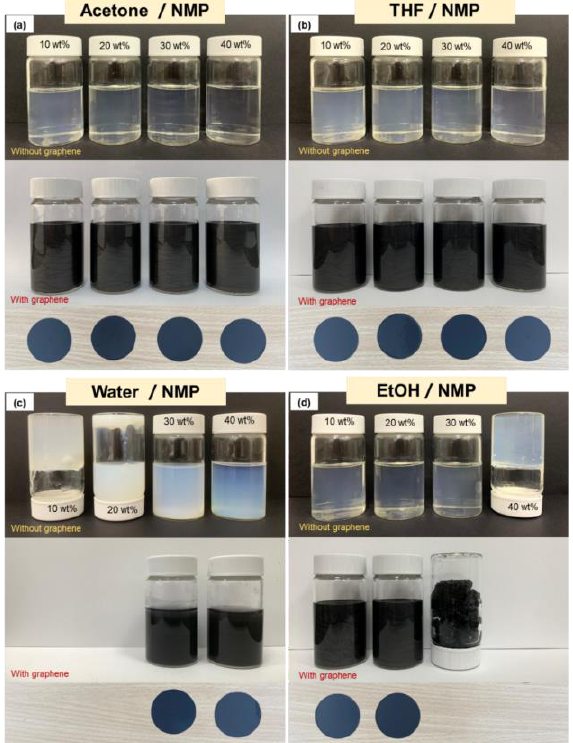
Figure 2. ( a ) Acetone/NMP; ( b ) THF/NMP; ( c ) water/NMP; ( d ) EtOH/NMP mixed solvent with PVDF and PVDF/graphene, the co-solvent concentration (acetone, THF, water, and EtOH) is 10 wt%, 20 wt%, 30 wt%, and 40 wt% from left to right.